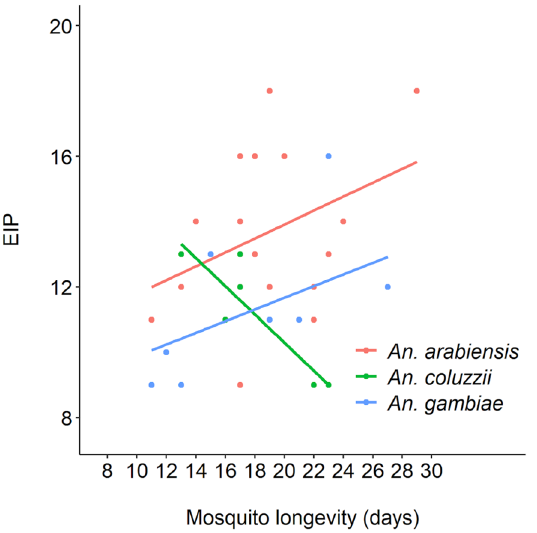
Figure 3. Relationship between the extrinsic incubation period (EIP) of Plasmodium falciparum and the lifespan of individual mosquitoes from three mosquito vector species.